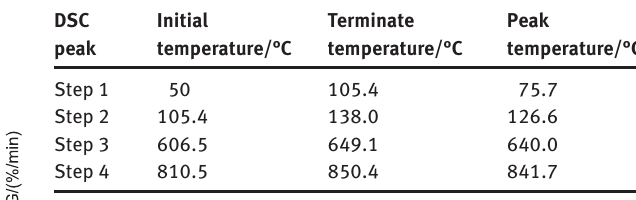
Table 2: Changes during heating according to the DSC